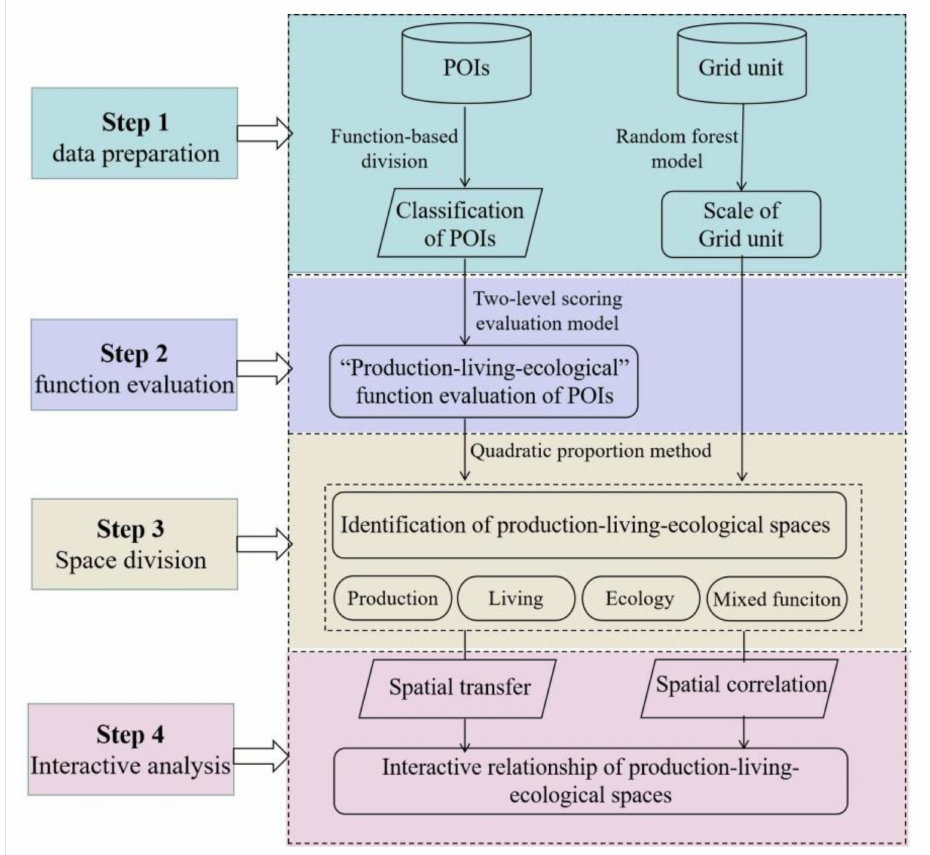
Figure 2. Method